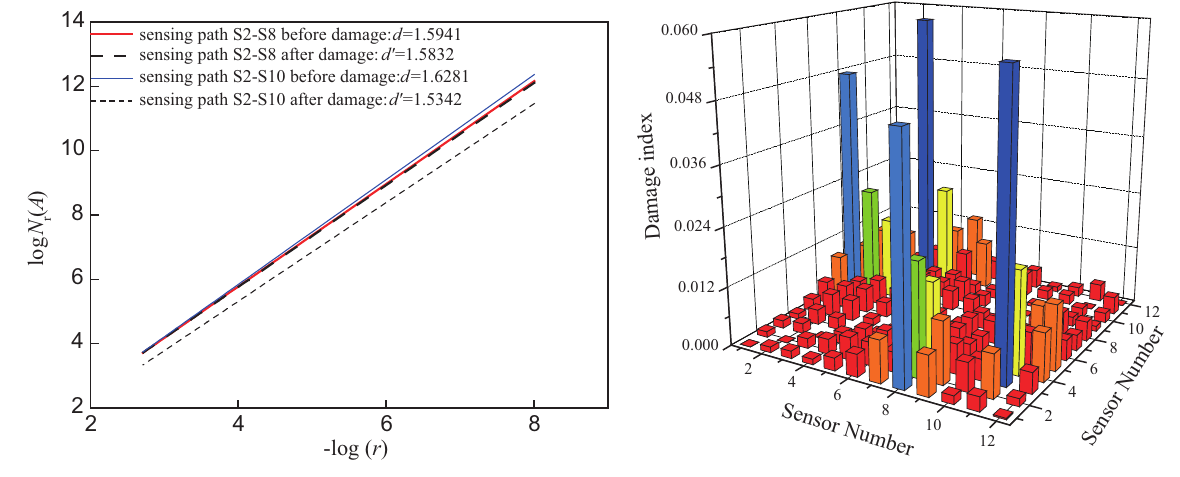
Fig. 7. Fractal dimensions of transmitter-receiver paths S2–S8 and S2–S10.